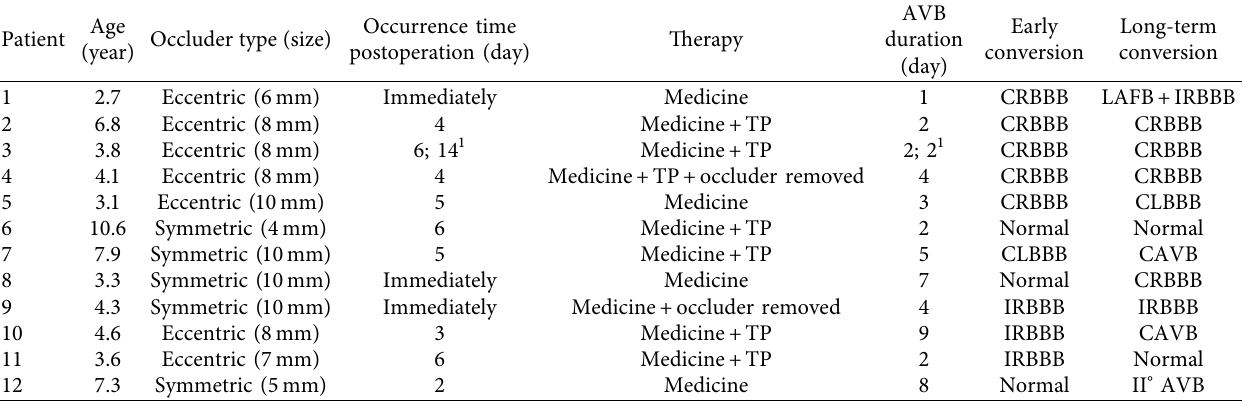
Table 4: Clinical data of patients with CAVB or high-degree